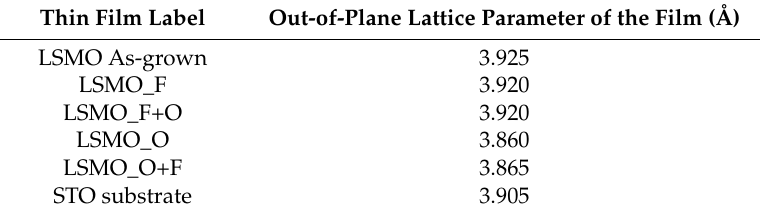
Table 2. Analysis of out-of-plane lattice parameters of the various LSMO films (for detailed preparation conditions, see Table 1). Numerical errors for the determined parameters from the Pawley fit are in the order of ± 0.001 Å, the tolerance from neglecting X-ray interference effects [28] was estimated to be below ± 0.005 Å for films of 20–25 nm